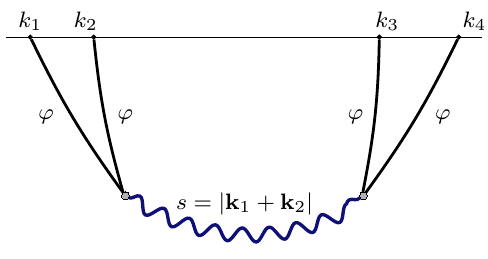
Figure 5 . The four-point exchange diagram of ϕ mediated by a massive